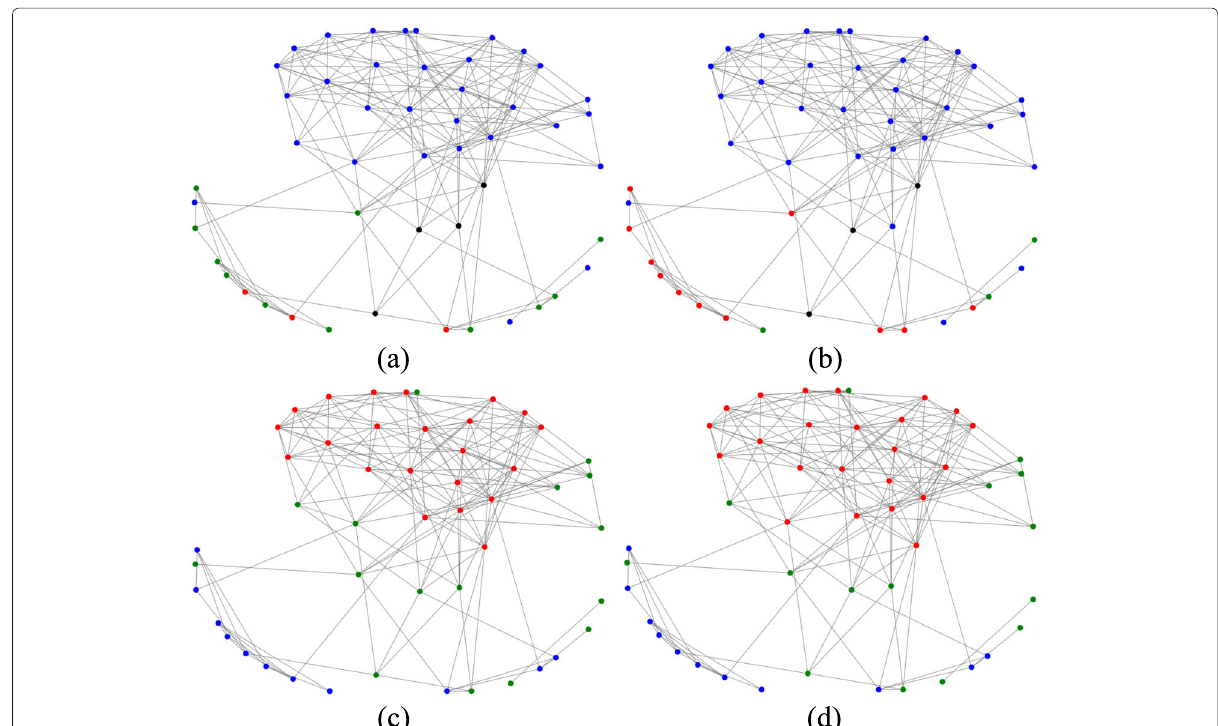
Fig. 5 Facebook ego-network with missing link probability (cid:3) 2 = 0.3: comparison of the two detected communities with the ground-truth by using the proposed noise-aware game-theoretic algorithm and the AGM in [15], respectively. The nodes’ colors have the same meaning as in Fig. 3. a Detection of community 1 with AGM; b Detection of community 1 with the proposed noise-aware game-theoretic algorithm; c Detection of community 2 with AGM; d Detection of community 2 with the proposed noise-aware game-theoretic